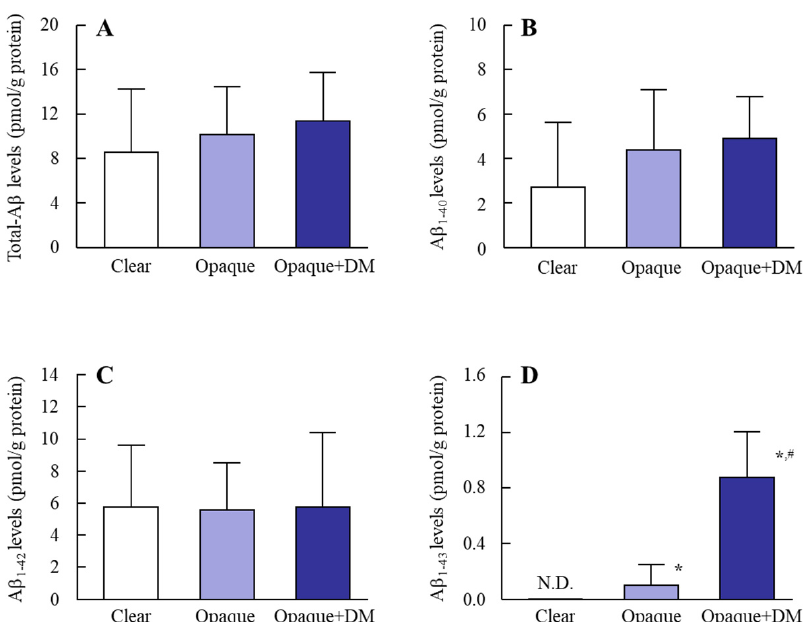
Figure 1. Changes in total-A β ( A ), A β 1–40 ( B ), A β 1–42 ( C ), and A β 1–43 ( D ) in lens epithelium of diabetic patients. Patient characteristics are shown in Table 1 (ELISA method group). Open columns, transparent lens epithelium; closed columns, opaque lens epithelium. Clear, transparent lens epithelium; opaque, opaque lens epithelium; opaque + DM, opaque lens epithelium with type 2 DM. n .D., not detectable. n = 5–18. * p < 0.05, vs. clear for each group. # p < 0.05, vs. opaque for each group.